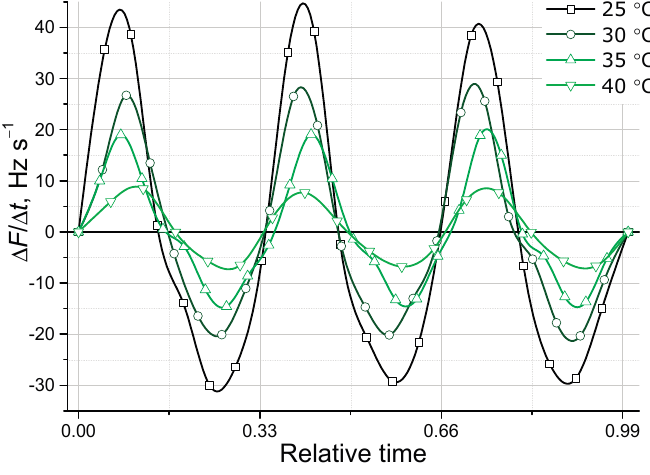
Figure 6. Comparison of the respiration response at different temperatures in case of the [PAH/SiO 2 ] 10 electrode infused with TSPP